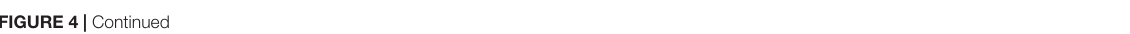
FIGURE 4 | Continued of nine imaging time points are shown for each condition. Left panel: overview; white frame indicates the area shown at high magnification on the right. Tracked cells are marked by white frames and GCs with high motility are indicated by arrows. OHSC were treated with 10 µ M KA for 45 min, followed by placement of beads. Uncoated fluorescent beads (A,C) or Reelin-coated (B,D) were positioned into the hilus. Each slice derived from a different animal (A) Control + uncoated beads ( n = 6 slices, 77 cells). (B) Control + Reelin-coated beads ( n = 7 slices, 89 cells). (C) KA + uncoated beads ( n = 4 slices, 70 cells). (D) KA + Reelin-coated beads ( n = 5 slices, 68 cells). (E) Quantitative evaluation of migration distances of individual GCs. Under control conditions with uncoated and with Reelin-coated beads, GCs do not change position. KA induces migration of GCs but this is strongly reduced by placement of Reelin-coated beads. (F) Diagram showing the directionality ratios of the different groups. Note that GCs of the KA + uncoated bead group have lower values than the two control groups. GCs of KA-treated OHSC with Reelin-coated beads present a ratio similar to controls. (G–J) Quantitative evaluation of migration distances of individual GCs in relation to their start distance from the beads. (G) Control + uncoated beads, (H) Control + Reelin-coated beads, (I) KA + uncoated beads. Note that in these group there is no correlation between effective migration distance and start distance from the beads of tracked GCs. (J) KA + Reelin-coated beads. A positive correlation (Pearson correlation coefficient r = 0.7461) between the initial position and the migration behavior of the eGFP-positive cells is apparent. One-way ANOVA followed by Tukey’s Multiple Comparison